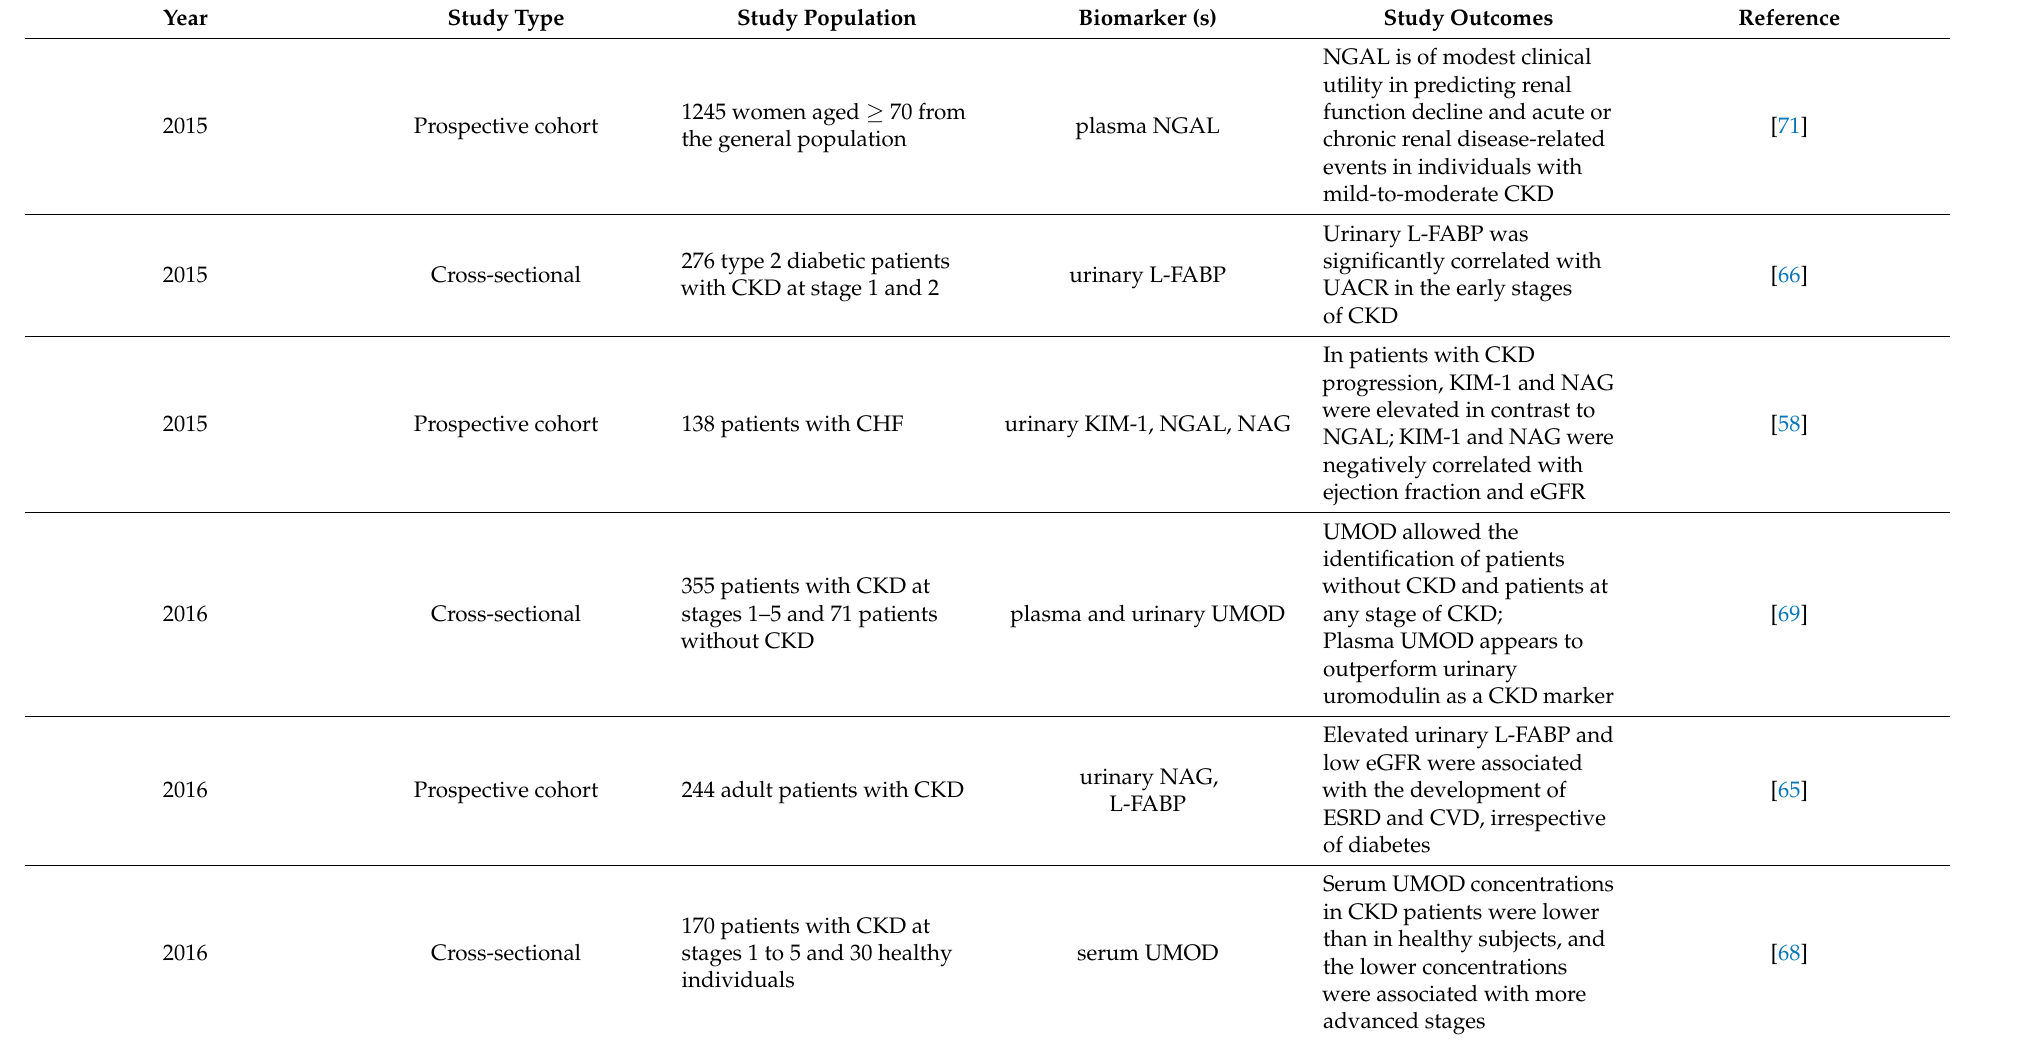
Table 2. Research studies on biomarkers of renal tubular lesions and main outcomes in CKD